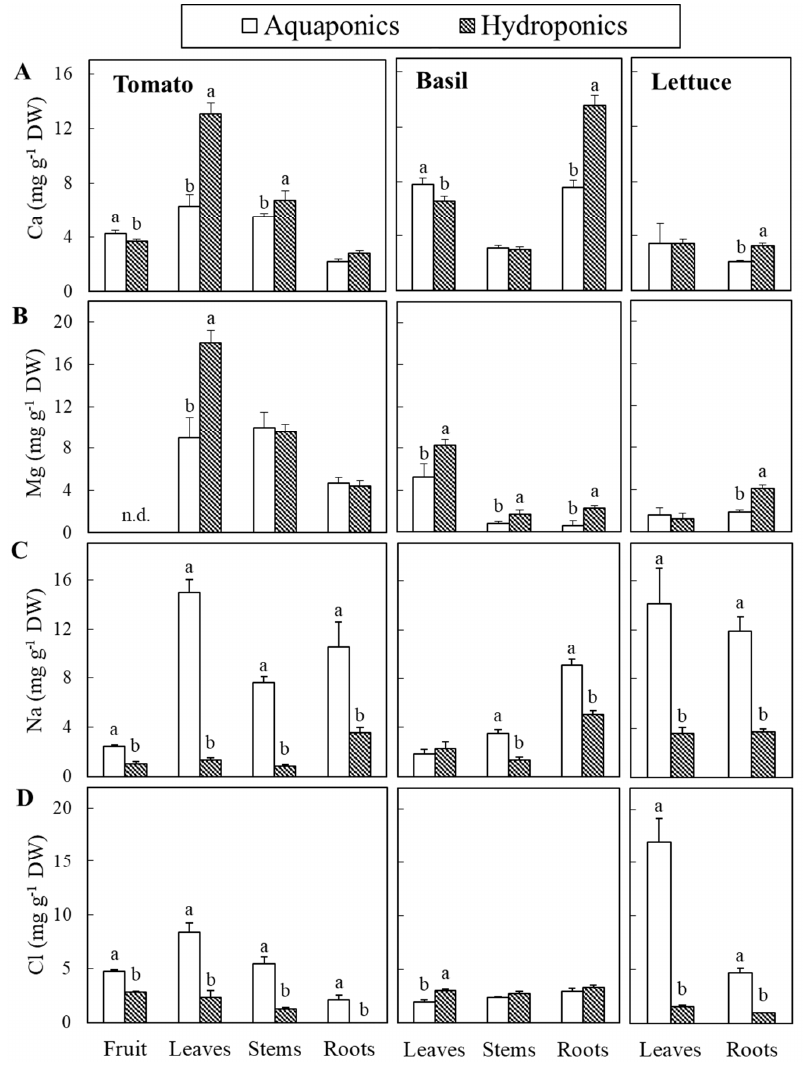
Figure 6. Calcium ( A ), magnesium ( B ), sodium ( C ), and chloride ( D ) concentrations in leaves, stems, roots, and / or fruit of tomato, basil, and lettuce grown for 3-, 3-, and 1-month(s) in an aquaponics or hydroponics system. Data represent the mean of 6 replicates ± SE. Table 9. Pearson’s correlation coe ffi cients of nutrient (total N, Ca, and Mg) concentrations in the leaves of tomato, basil, and lettuce for SPAD value.